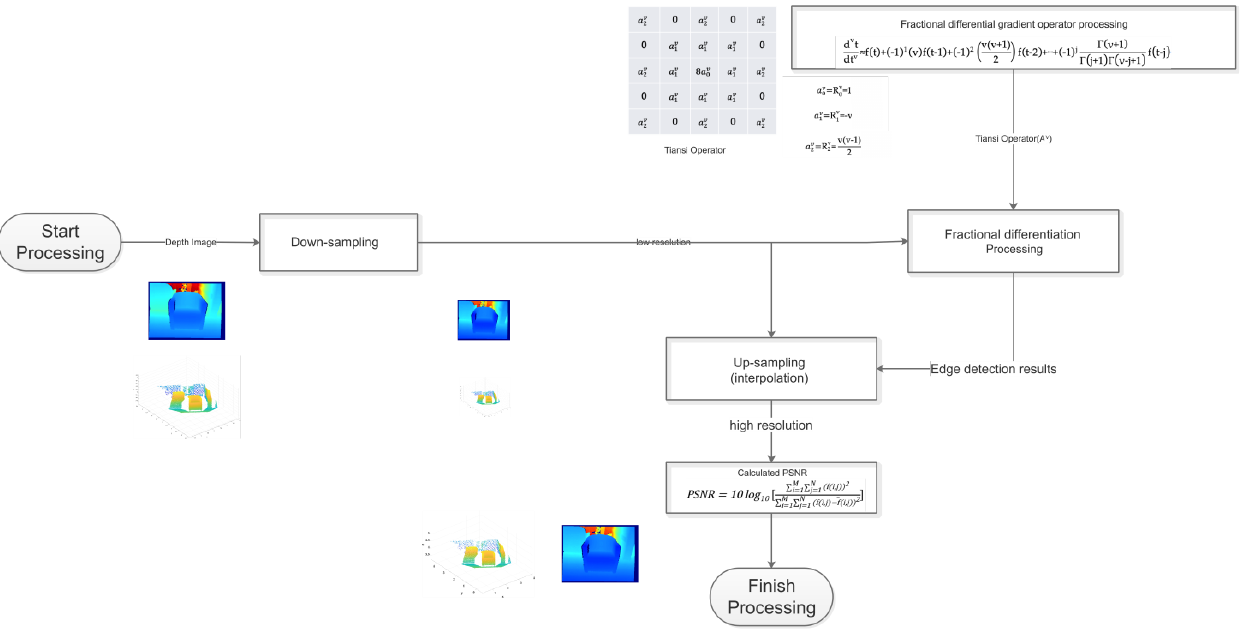
Figure 10. super−resolution flow chart. Figure 10. Super-resolution flow